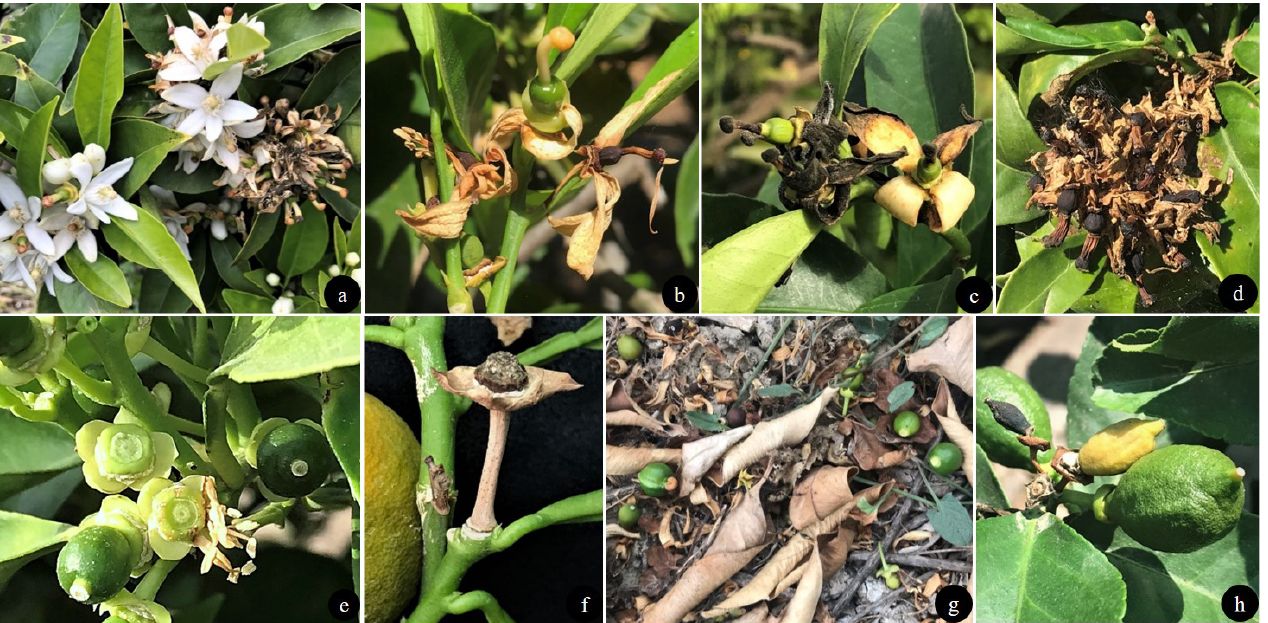
Figure 1. Early fruit drop: ( a – d ) blight and necrosis of citrus inflorescence; ( e ) fruitlets drop as a consequence of suberization of calyx tissue; ( f ) blight of persistent calyx; ( g ) abnormal early fruit drop; ( h ) early fruit drop.